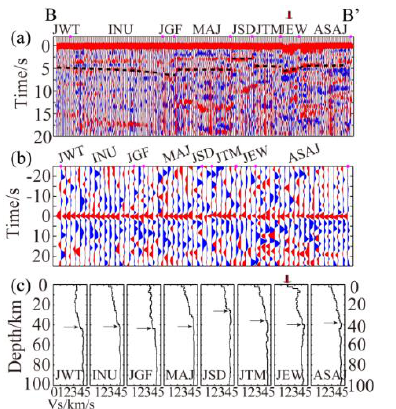
Figure 4: The same as Figure 3, but for profile B- B’ (location shown in Figure 1). The profile C- C’ (Figure 5) passes through the center of Japan Islands along southwest-to-northeast direction (Figure 1). The Moho appears much deeper and with good con-